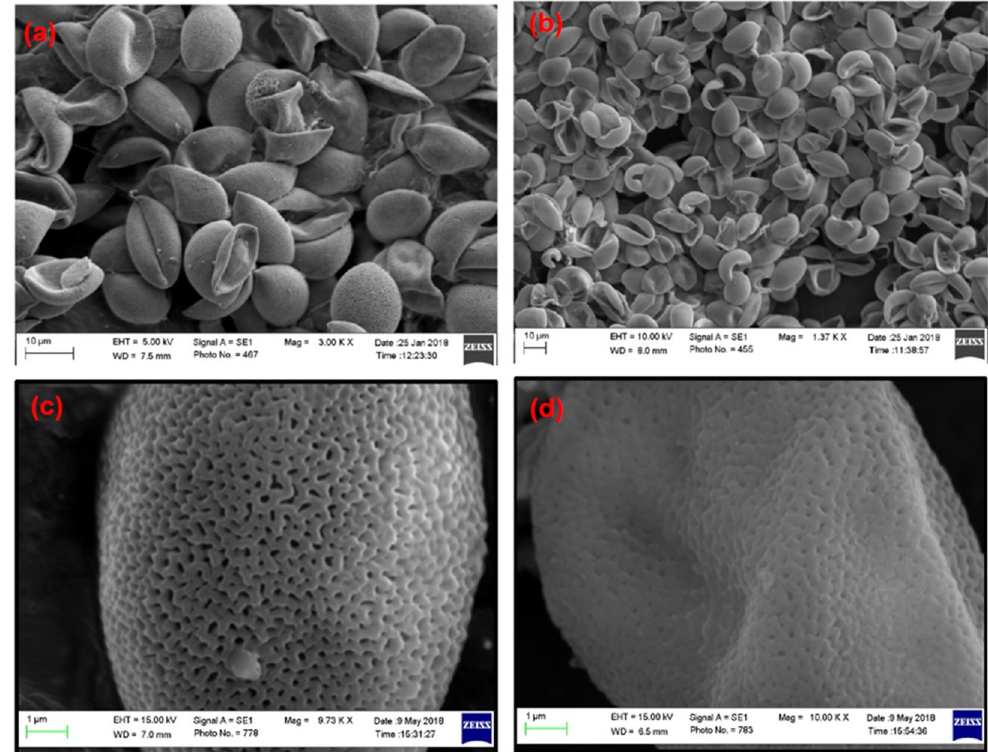
Figure 1. SEM images of 5-FU-loaded SEMC: ( a , c ) are the images for F2-uncoated while ( b , d ) are for Eudragit ® RS-100-coated F2.